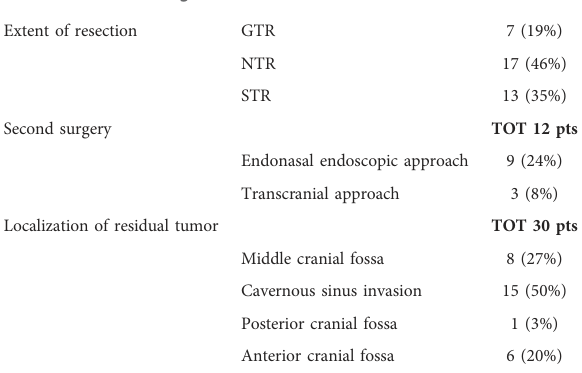
TABLE 2 Detailed surgical